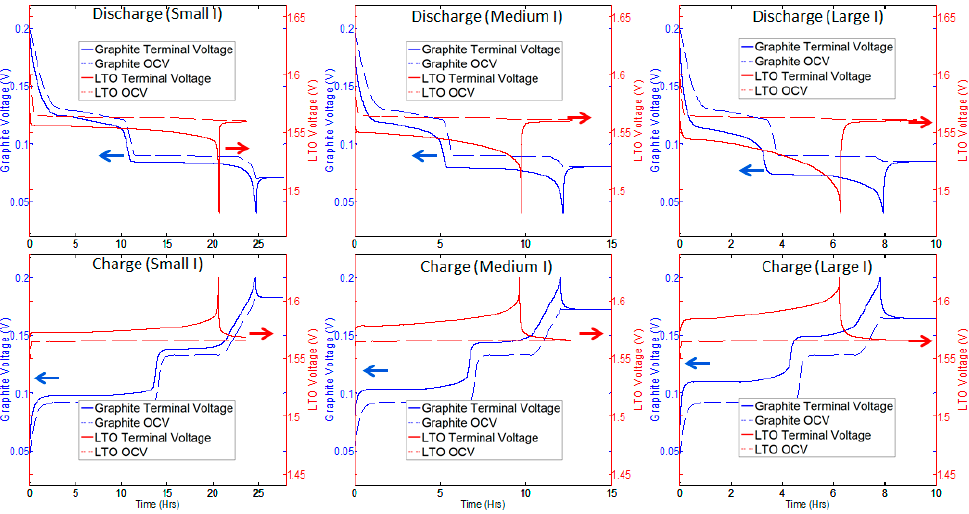
Figure 4. Terminal voltage comparison of simulated graphite and LTO half-cells cycled with constant current at 0.045 C, 0.089 C and 0.13 C.